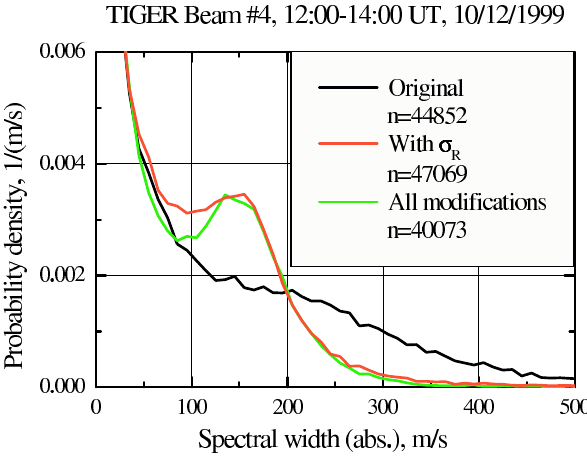
Fig. 7. Spectral width histograms for data presented in Fig. 5 (unmodified FITACF, black), Fig. 6 (without subtracting fluctuation level, red), and after applying all changes proposed in Sect. 3.4. Both modified algorithms essentially confine W to ∼ 250m/s.